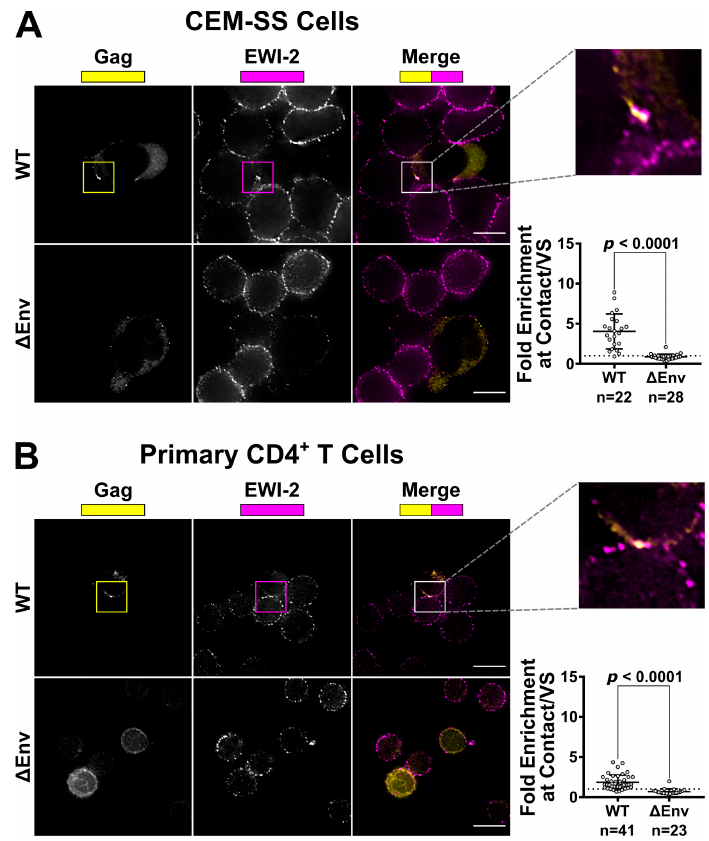
Figure 1. EWI-2 co-accumulates with Gag at the HIV-1 VS in T cells. ( A ) CEM-SS cells infected with HIV-1 NL4-3 WT or ∆ Env were co cultured with uninfected CEM-SS target cells for 5 h, and subsequently stained for surface EWI-2 (magenta) and Gag (yellow). The EWI-2-associated fluorescence intensity at cell–cell contacts either enriched with Gag (WT) or not Gag-enriched but identified by DIC ( ∆ Env) was measured. This value was then divided by the sum of the EWI-2-associated fluorescence intensity on non-contact sites on the producer and target cell in each VS / contact to yield EWI-2 enrichment (i.e., the values shown here). The data quantified are from one biological replicate consisting of two technical replicates. Similar trends were observed in a second dataset; not shown. ( B ) Primary CD4 + T cells infected with NL-sfGI WT or NL-CI ∆ Env were co-cultured with uninfected target primary cells for 2 h and stained for EWI-2 (magenta) and Gag (yellow), followed by secondary pAbs (Alexa Fluor 647-conjugated for EWI-2, and either Alexa Fluor 594 or Alexa Fluor 488-conjugated for Gag in the case of WT and ∆ Env, respectively). Because di ff erent secondary antibodies were used for Gag in either condition, the scaling shown for that channel is not the same across the two conditions and was based on corresponding primary and uninfected controls done alongside each dataset. Enrichment of EWI-2 at Env-dependent (WT) or Env-independent ( ∆ Env) infected-uninfected cell contacts was quantified as described in ( A ). The data quantified are pooled from two independent biological replicates, each consisting of two technical replicates. Scale bars = 10 µ m. In both data plots, each data point represents one cell–cell contact site (as opposed to one cell). The dotted horizontal line indicates a theoretical fold enrichment value of 1, which indicates no enrichment. Error bars = standard deviation of the mean (SD). p -values are the result of two-tailed non-parametric Mann-Whitney U tests. To determine whether EWI-2 enrichment at the VS takes place within the infected cell, i.e., at the presynaptic terminal (rather than the apposed uninfected target cell), HIV-1-infected CEM-SS